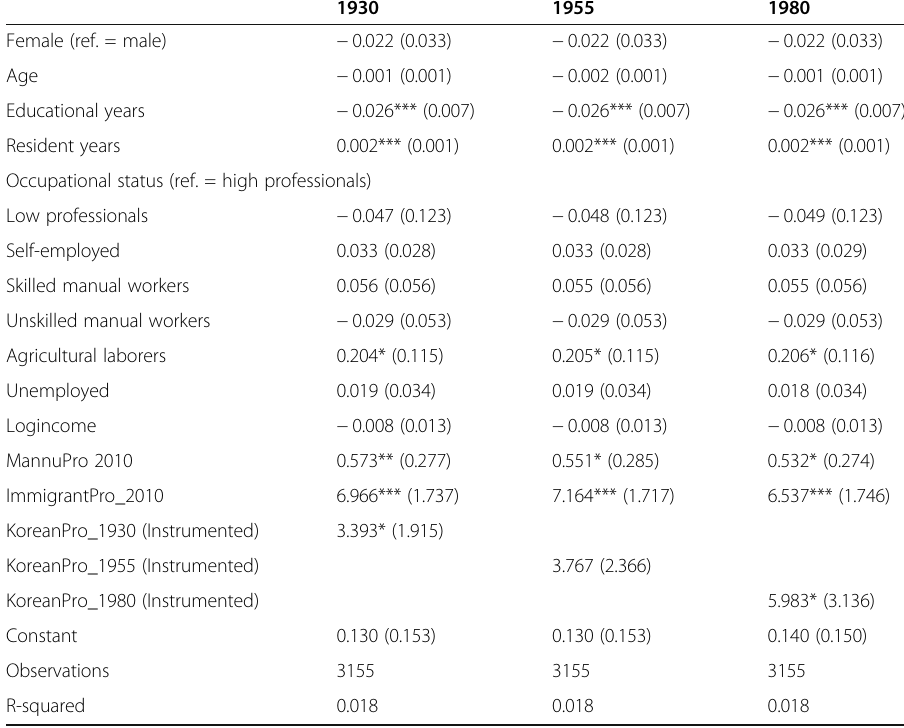
Table 8 Regression models of Japanese residents ’ xenophobia (instrumented) 1930 1955